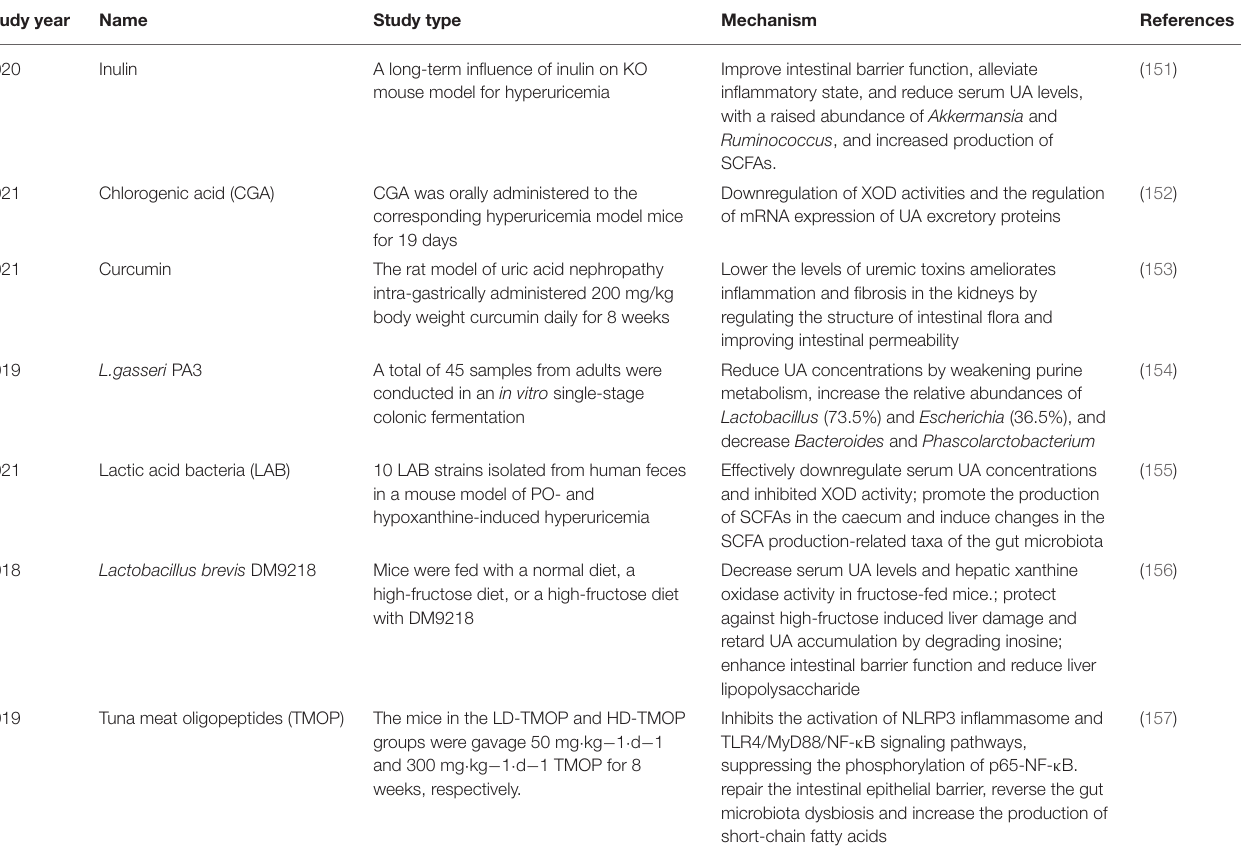
TABLE 1 | Probiotics and prebiotics in management of hyperuricemia and